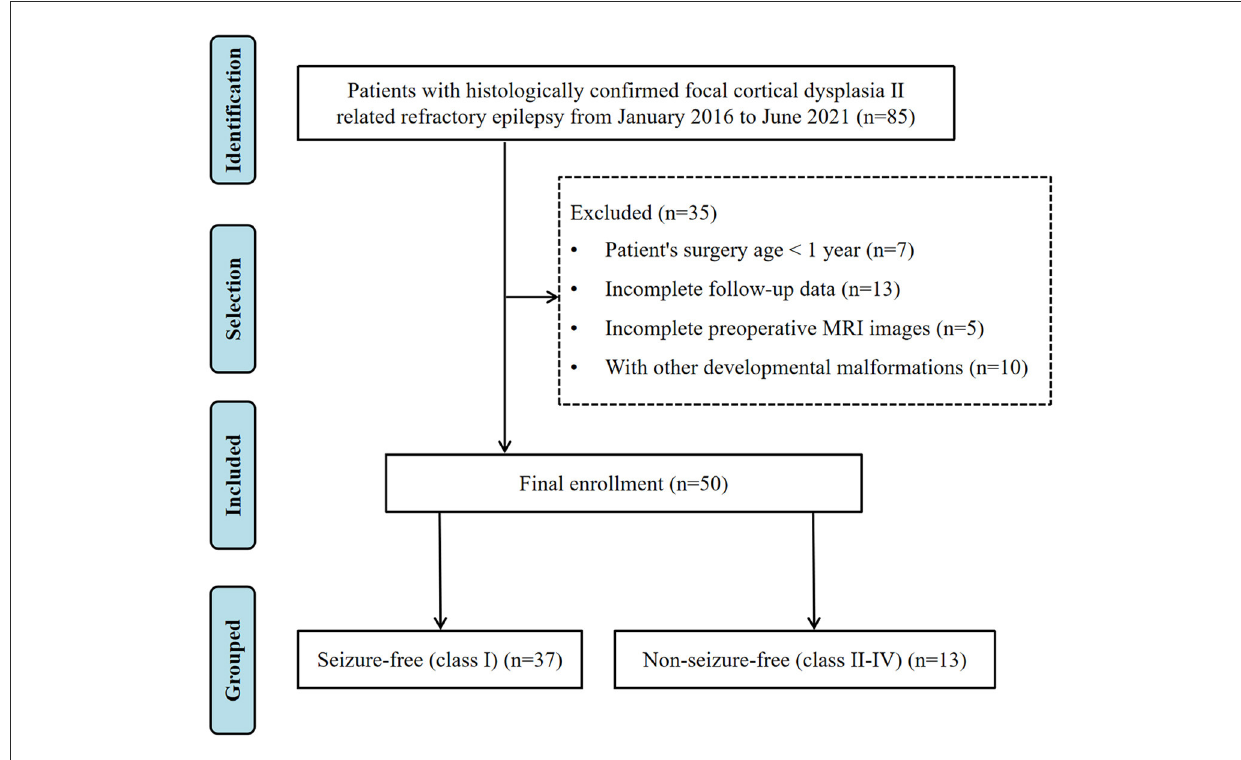
FIGURE1 Flowchart of patient